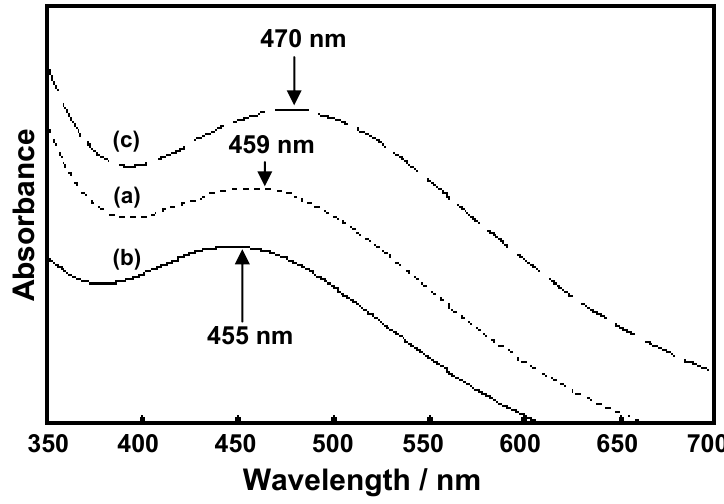
Figure 7. UV-Vis absorption spectra of complexes in ethanolic solution: Ce(III)- BM1 , (b) Ce(III)- BM2 , and (c) Ce(III)- BM3